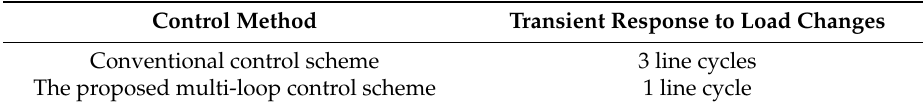
Figure 13. Reference and actual voltages of the four-leg grid-forming unit in phase ‘c’ in the rotating frame with the proposed control strategy. Table 2. Transient performance of two control strategies.